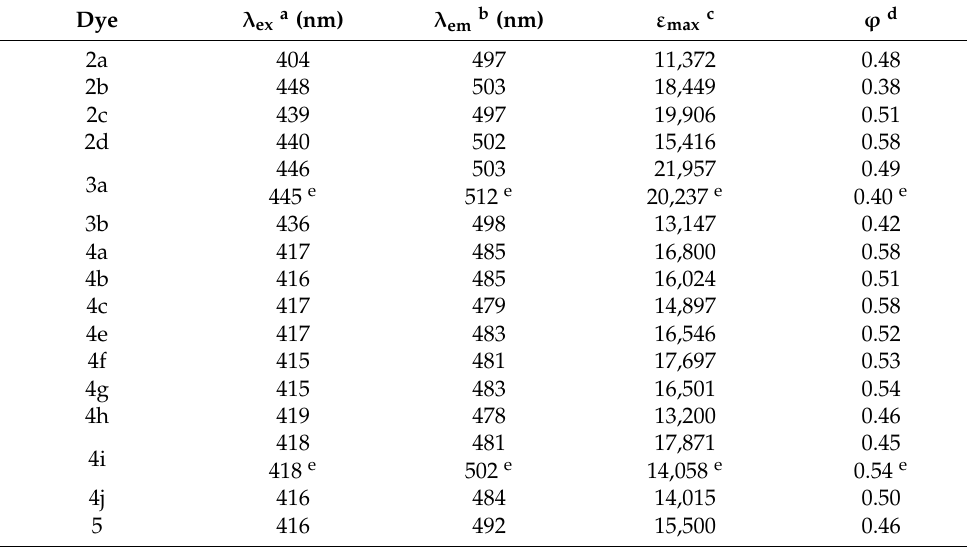
Table 1. Spectroscopic characterization of functionalized PyTAP in CH 2 Cl 2